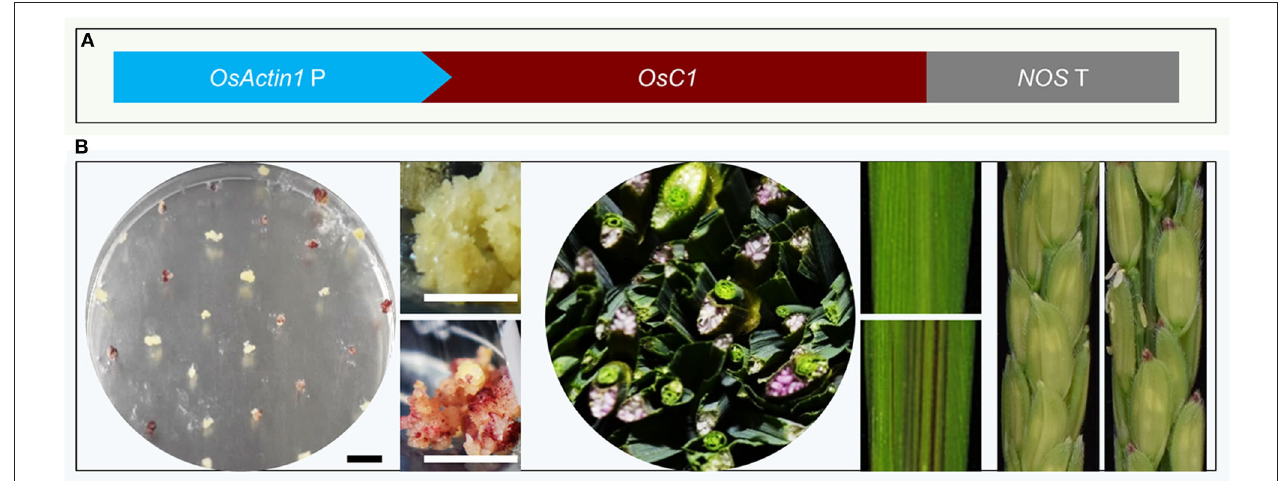
FIGURE 1 | The pACTIN-OsC1 activates anthocyanin biosynthesis in rice. (A) A schematic description of the pACTIN-OsC1 unit in the vector used for rice transformation. The anthocyanin regulation gene OsC1 is under the control of the rice OsACTIN1 promoter. NOS T refers to the terminator of the nopaline synthase gene from Agrobacterium tumefaciens . (B) The AAC plasmid induced obvious accumulation of anthocyanin (purple color) in rice calli, vascular tissue in stems (transverse section), leaves, and the tip of grains. Scale bars 1cm in tissue culture